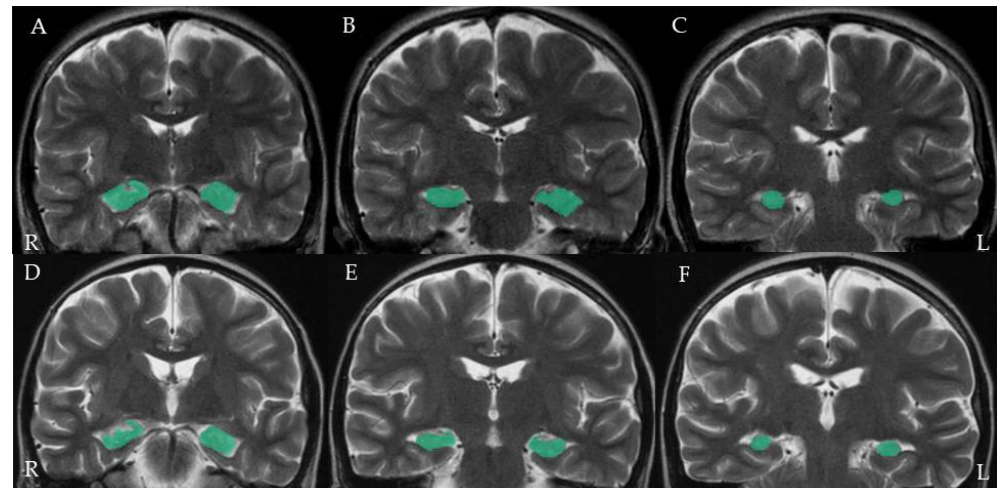
Figure 2. A coronal T2-weighted image of the brain for patient 1. The three hippocampal segments (head, body, and tail) before transplantation ( A – C ) and after transplantation ( D – F ) are shown in green.